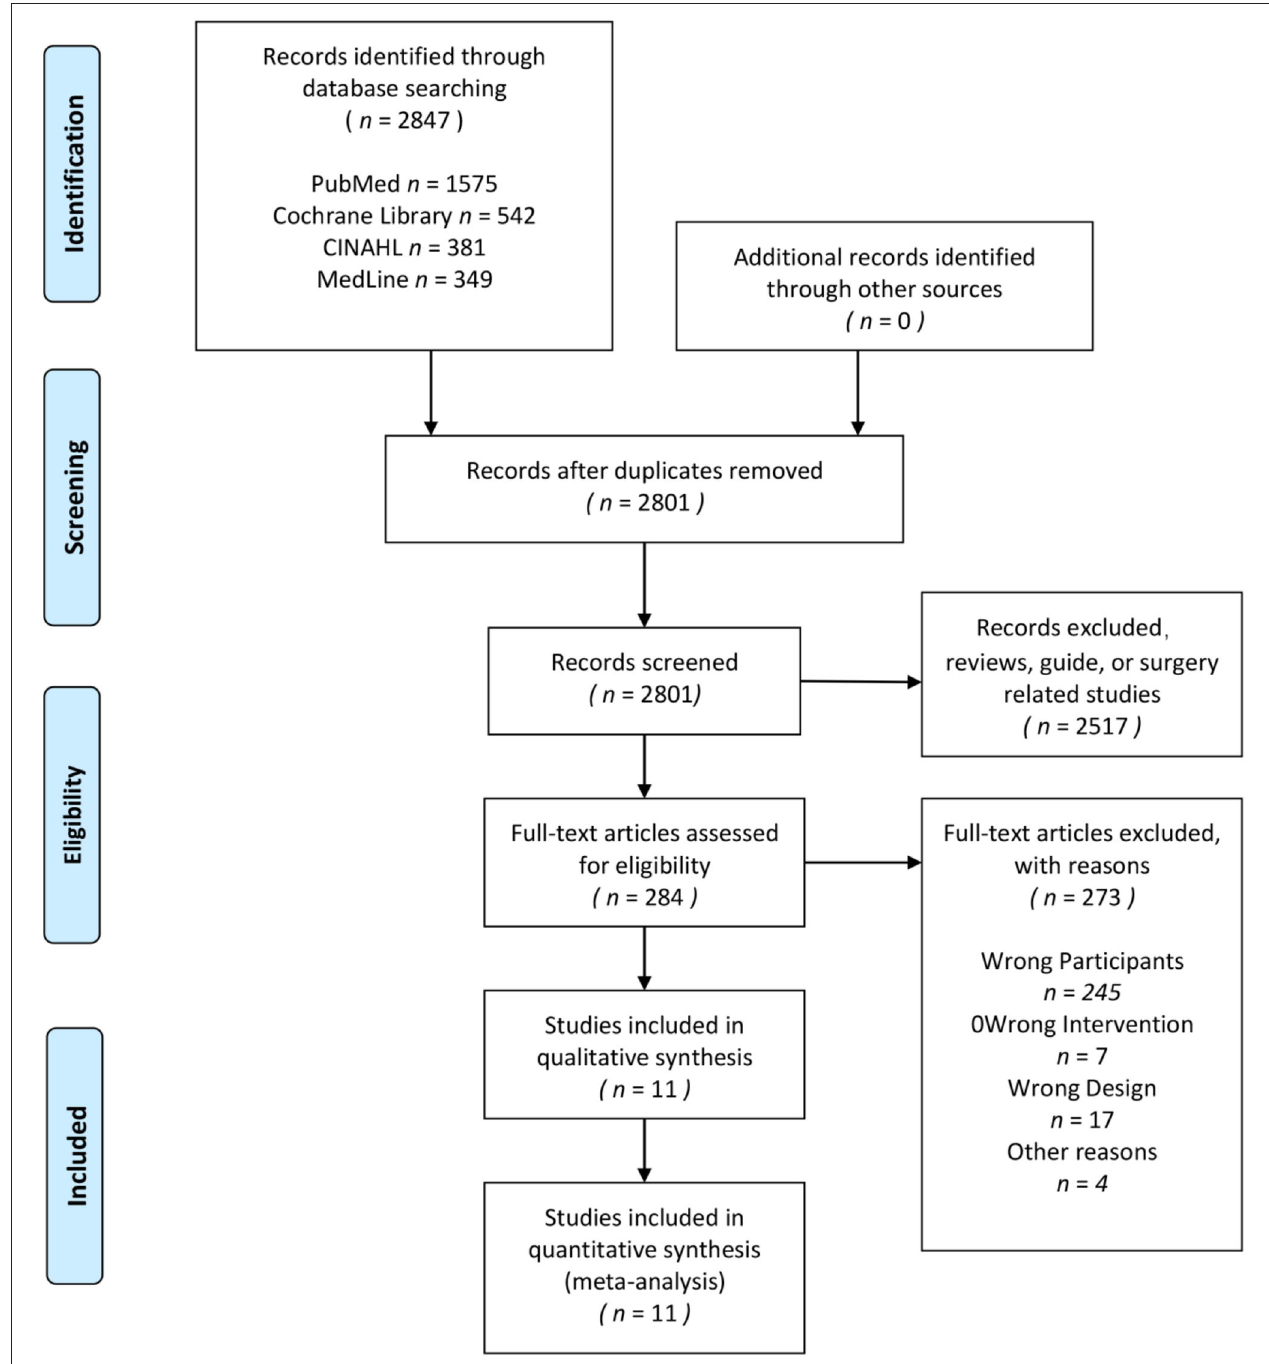
FIGURE 1 | PRISMA flow diagram for the systematic review and network meta-analysis.